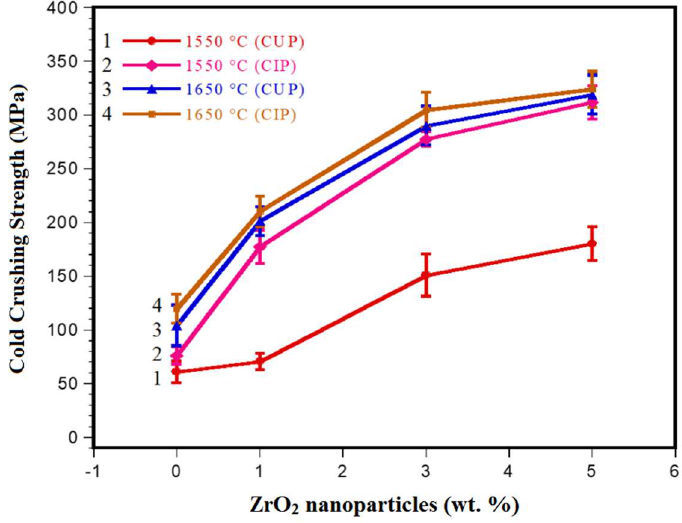
Figure 5. Variations in the cold crushing strength (CCS) of magnesia refractories with different contents of ZrO 2 nanoparticles formed by CUP or CUP + CIP and sintered at 1550 °C and 1650 °C.